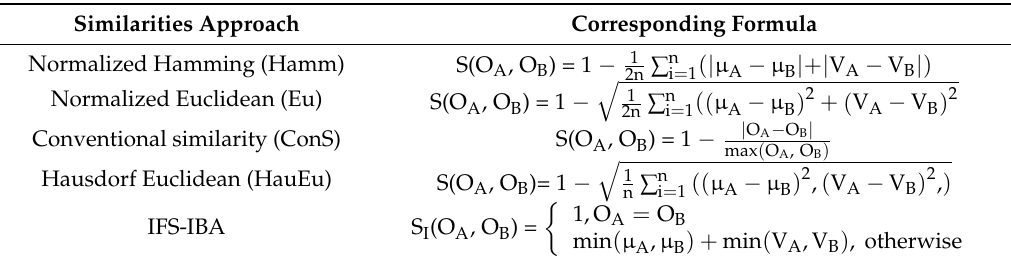
Table 5. The five similarity